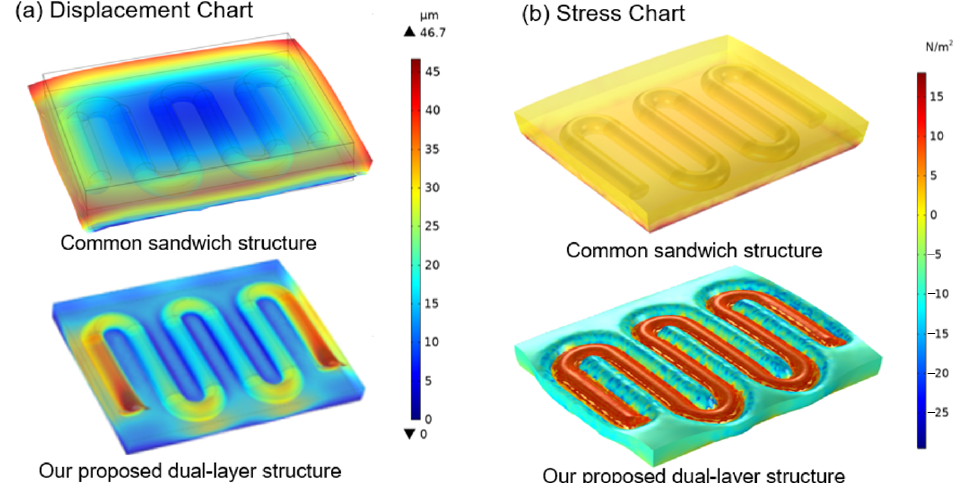
Figure 8. Comparison of simulation results on the ( a ) displacement chart and ( b ) stress chart for the microfiber sensor between the common sandwich structure with the upper layer and our proposed dual-layer structure without the upper layer under external pressure.